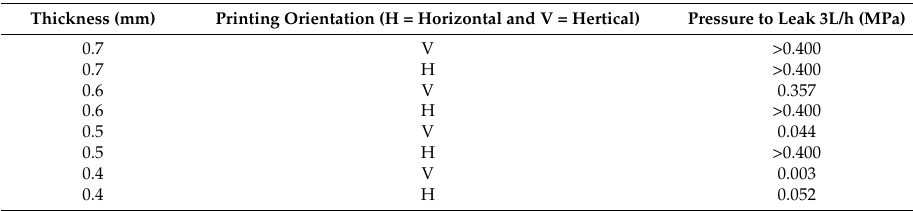
Table 5. Pressure drop for a leak value of 3